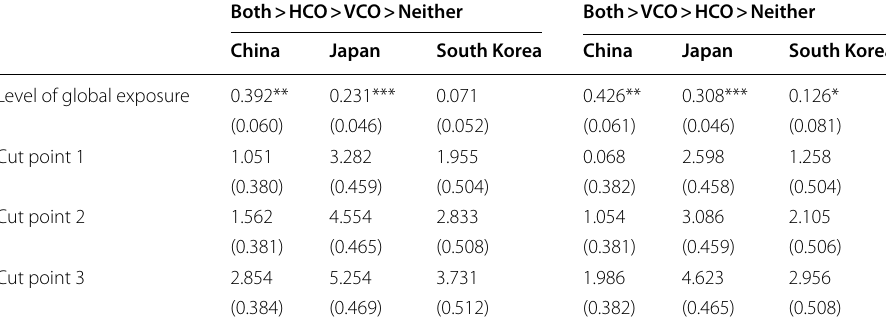
Standard errors in